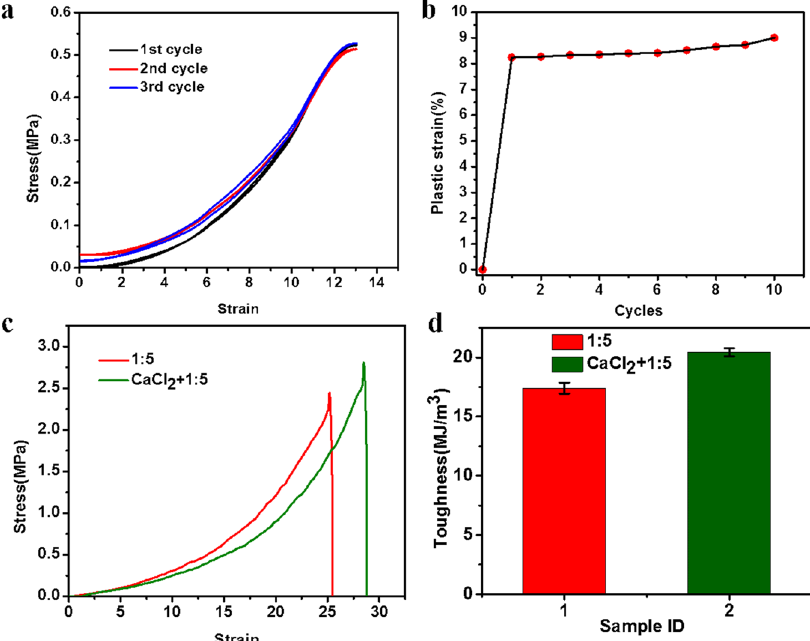
Fig. 5 Tensile recovery properties of hydrogels and effects of ions on mechanical properties of hydrogels. a Cyclic loading − unloading tensile curves of the Hy- α -CD/ACA-PEG 20000 -ACA hydrogel (ACA-PEG 20000 -ACA: Hy- α -CD = 1:5) at 1300% strain for three cycles (no waiting time between cycles). b Plastic strain as a function of cycle times at strain of 1100% (no waiting time between cycles, ACA-PEG 20000 -ACA: Hy- α -CD = 1:5). c Tensile stress − strain curves of hydrogel doped with CaCl α -CD = 1:5). d Fracture energy of 2 compared with the hydrogel without CaCl 2 (ACA-PEG 20000 -ACA: Hy- hydrogel doped with CaCl 2 compared with the hydrogel without CaCl 2 (ACA-PEG 20000 -ACA: Hy- α -CD = 1:5). (Error bars indicate the average value and certain error obtained from three experiments for every